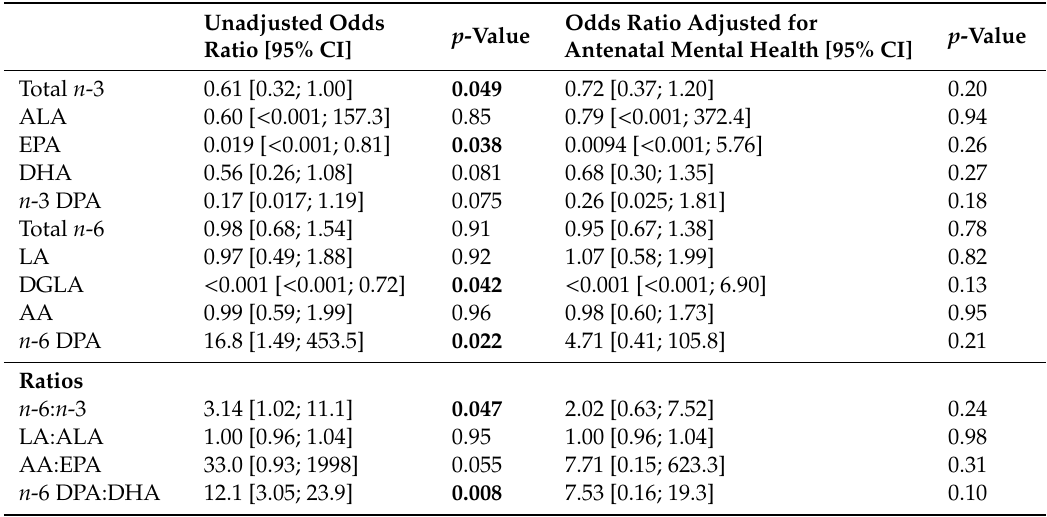
Table 4. Maternal red blood cell levels of omega-3 polyunsaturated fatty acids ( n -3 FA), n -6 FA and n -3: n -6 FA ratios at week 32 of gestation and odds ratios (OR) of postpartum depression. Columns 2 and 3 present odds ratios [95% CI] and p -values from the unadjusted model; Columns 4 and 5 present odds ratios [95% CI] and p -values from the model adjusted for antenatal mental